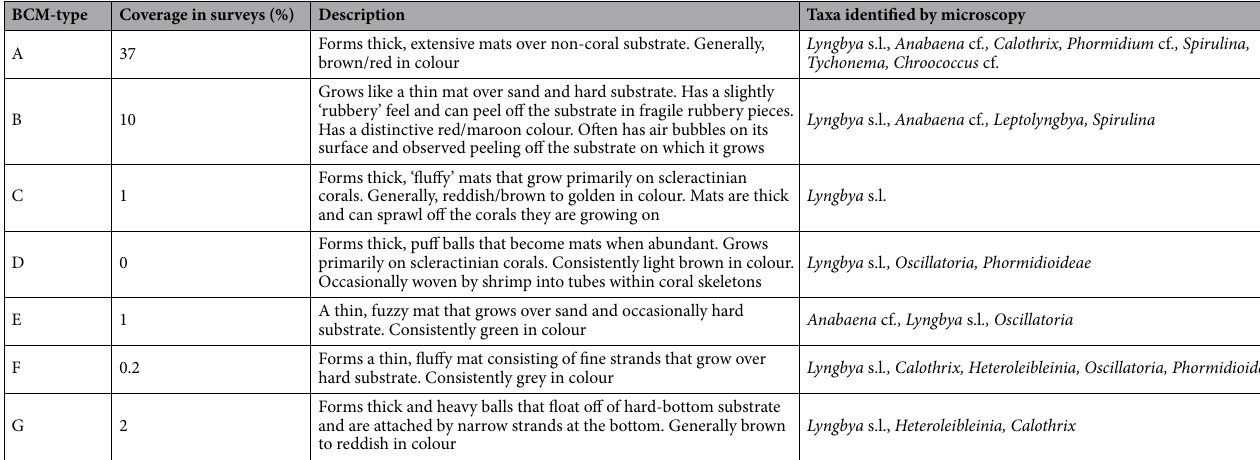
Table 1. BCM-types (A–G; refer to Fig. 2 for photographs), descriptions of their morphology, and lists of taxa identified by microscopic